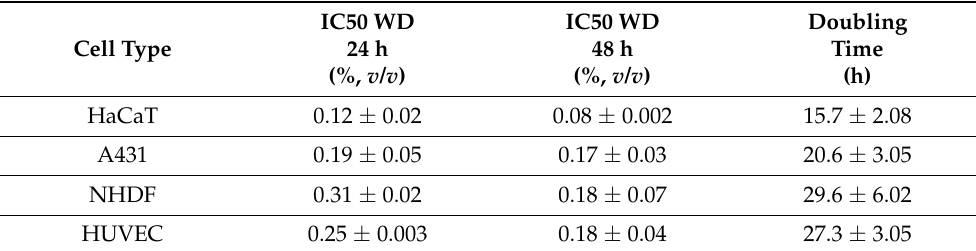
Table 1. Relation between IC50 of WD on cell viability and the doubling time of each cell type. IC50 of WD, at 24 and 48 h, on keratinocytes (HaCaT), model of mucosal epithelial cells (A431), fibroblasts (NHDF) and endothelial cells (HUVEC) was calculated by Quest Graph™ IC50 Calculator. These values were put in relation with the doubling time of each cell line, assessed during the exponential growth phase by Doubling Time software. Pearson’s correlation coefficient (r) of 0.9864 ( p = 0.0136) defined the relation between IC50 of WD and doubling time after 24 h, and r value of 0.8515 ( p = 0.1485) defined that after 48